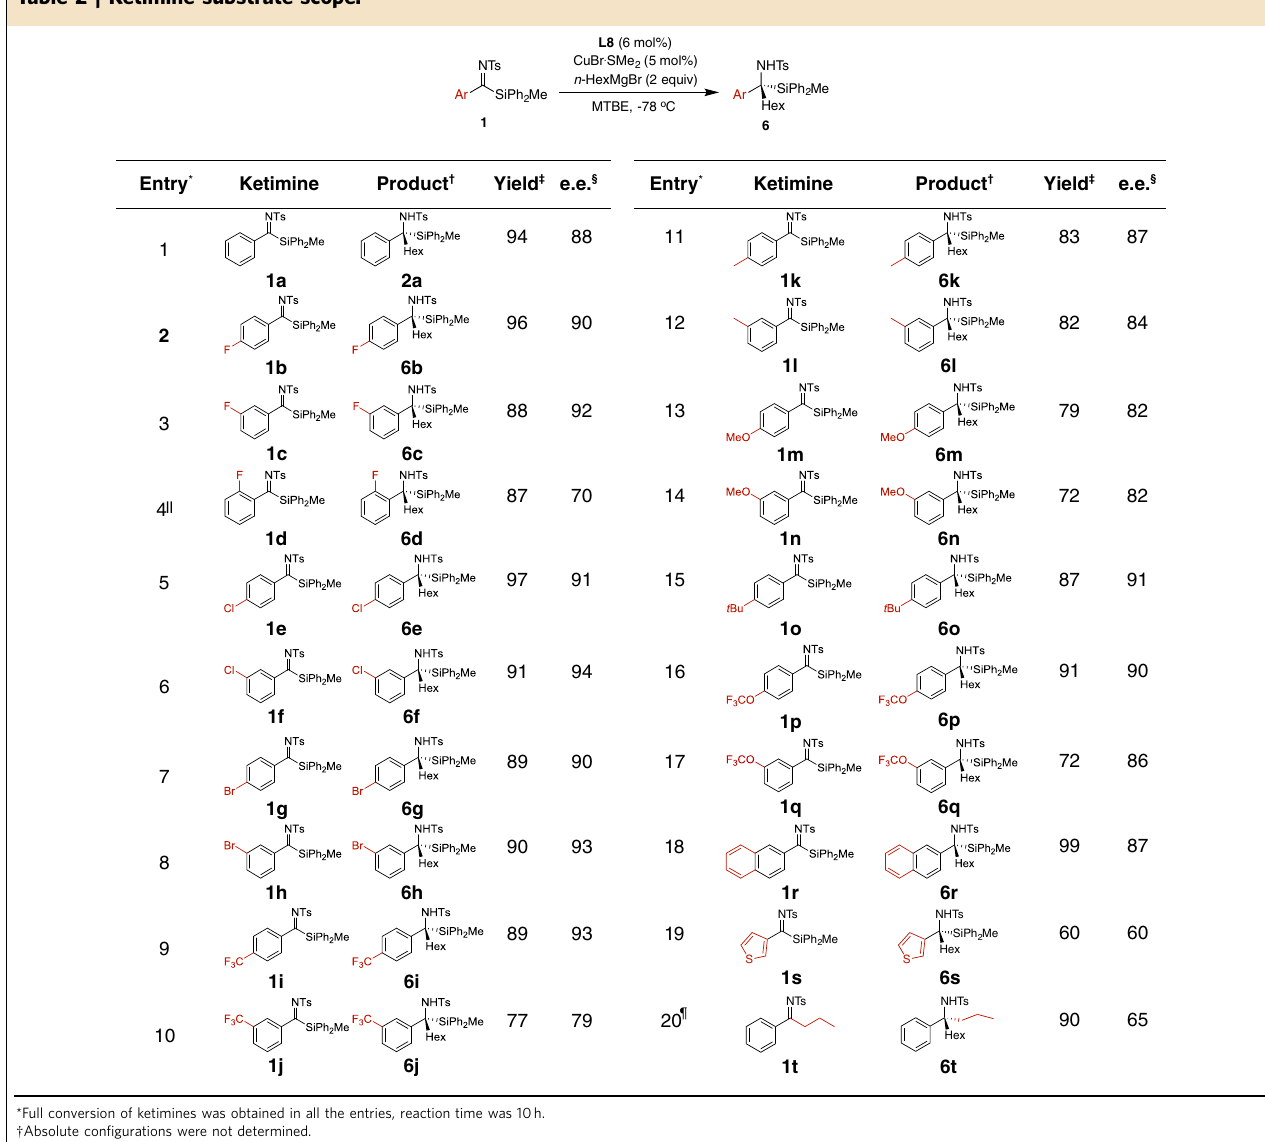
Table 2 | Ketimine substrate